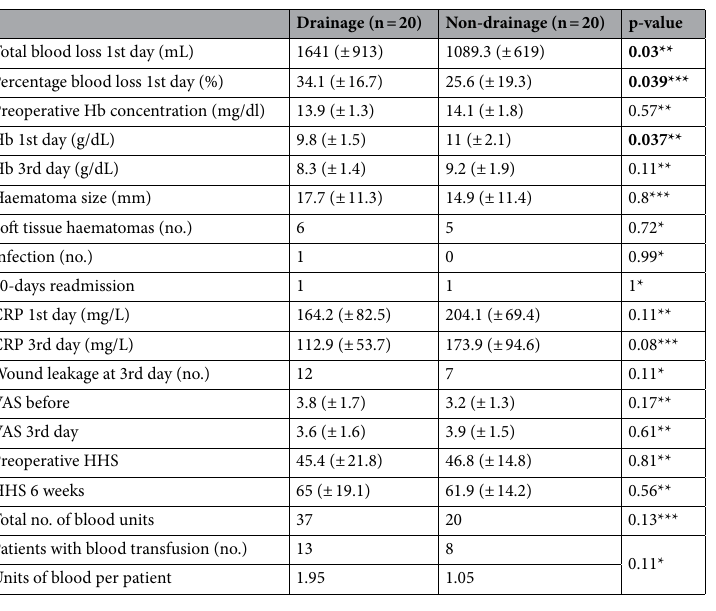
Table 3. Primary and secondary outcomes. Significant values are in bold. *Chi 2 Test (2 × 2). **Student T